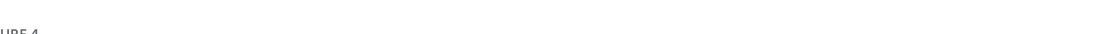
FIGURE4 experimental time-line: the real time conditioned place preference (RT-CPP) consisted of the pretekst (day 1), conditioning (days 2-3) and posttest (day 4). During the pretest and posttest rats had free access to both chambers of apparatus for 15 min, without photo-stimulation. During the conditioning one chamber was paired with laser photo-stimulation (473 nm, 10 ms light pulses at 60 Hz for 6 s at 12 s interval) or laser photo-inhibition (561 nm, 6 s at 12 s interval) and the other with no stimulation (control chamber). (B) There were no initial differences in time spent in conditioning chambers during pretest in control, photo-inhibited (Arch 3.0) and photo-stimulated (ChR2) cocaine-abstinent rats (chamber: F ( 2 , 96 ) = 209.7, p = 0.001; followed by post hoc test p < 0.01; treatment: n.s.; treatment × chamber: n.s.). (C) Photo-stimulation and photo-inhibition of LC noradrenergic efferents in VTA in cocaine-abstinent rats did not induce place preference or aversion as shown by the analysis of% of time spent in the laser-paired chamber. (D) These photo-modulation were insufficient in supporting the acquisition of conditioned place preference/aversion measured during posttest as shown by CPP score measure. (E) There were no initial differences in time spent in conditioning chambers during pretest in control and photo-stimulated cocaine-naïve rats (chamber: F ( 2 , 39 ) = 72.55, p = 0.0001; followed by post hoc test p < 0.01; treatment: n.s.; treatment × chamber: n.s.). (F) Photo-stimulation of LC noradrenergic efferents in VTA in cocaine- naïve rats did not induce place preference or aversion as shown by the analysis of% of time spent in the laser-paired chamber.